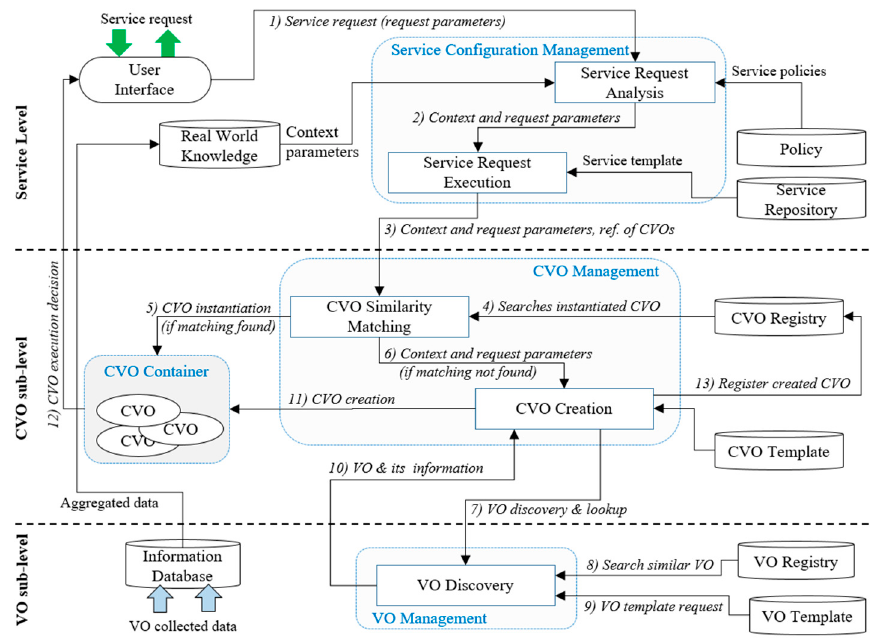
Figure 7. Logistic model to support service modularity in the Web of Objects (WoO) platform.